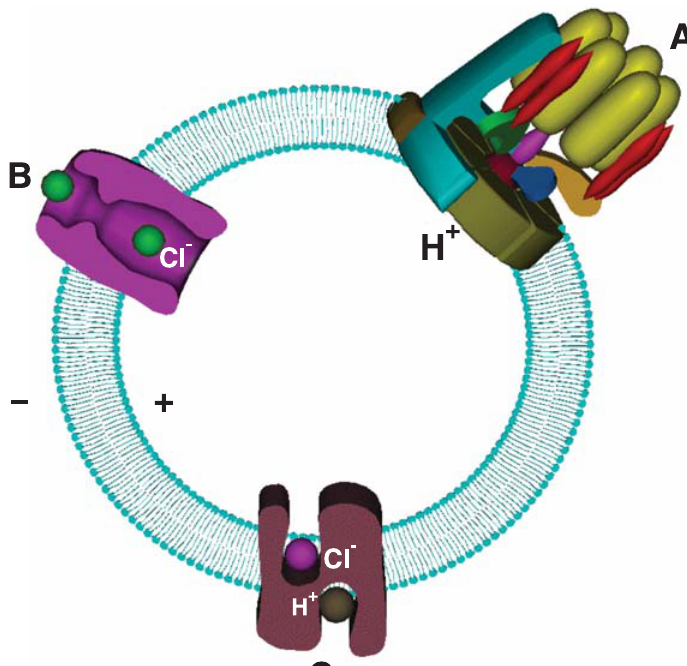
Figure 2. Counter-ion conductance